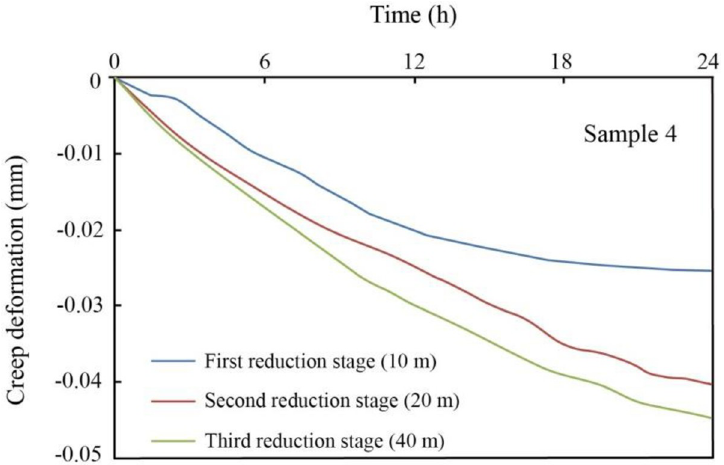
Fig 7. Creep deformation within 24 hours after each reduction stage, taking sample 4 as an